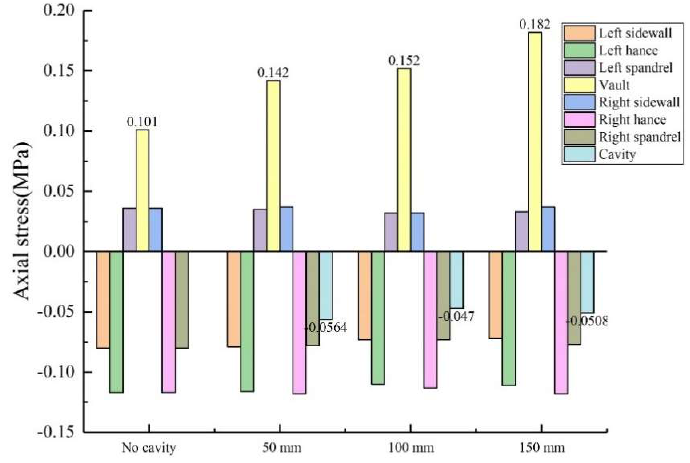
Figure 15. Variation of axial stress with vault void length.